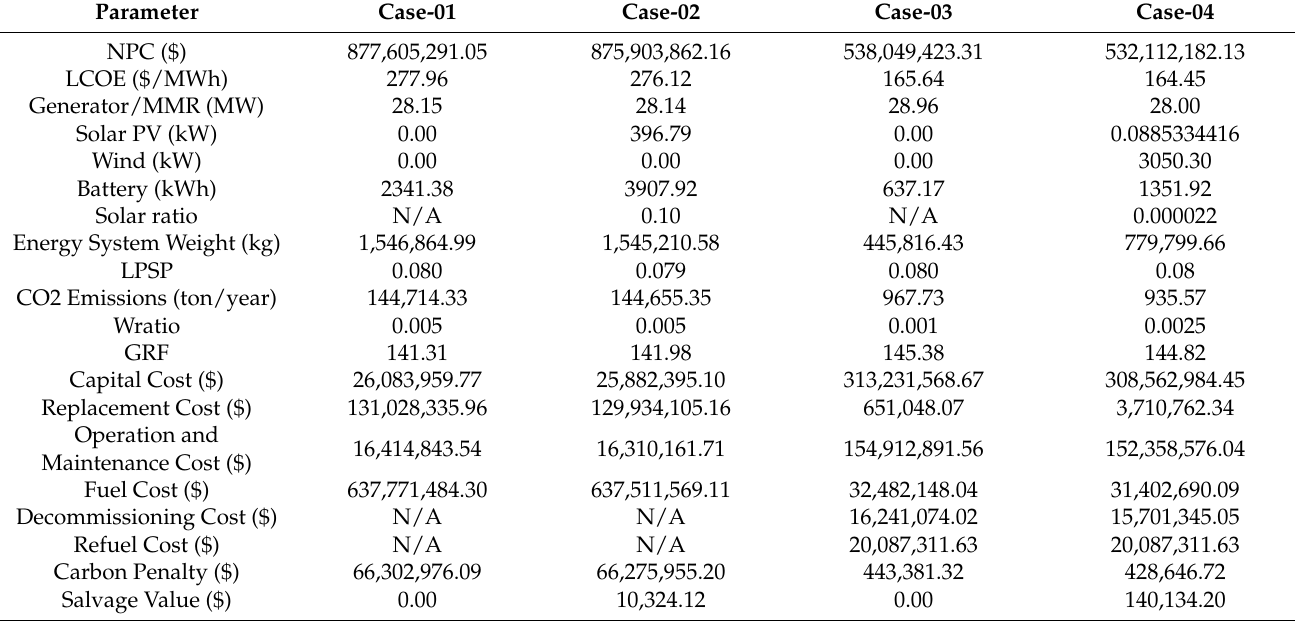
Table 1. Result of Optimization of Different Energy